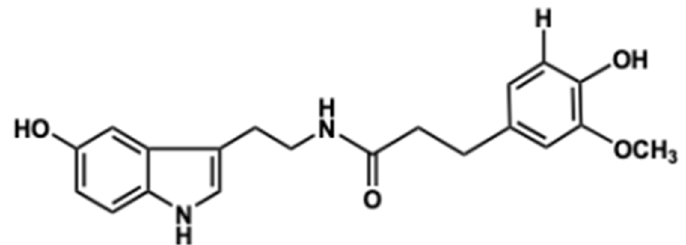
Figure 1. N -feruloyl serotonin.